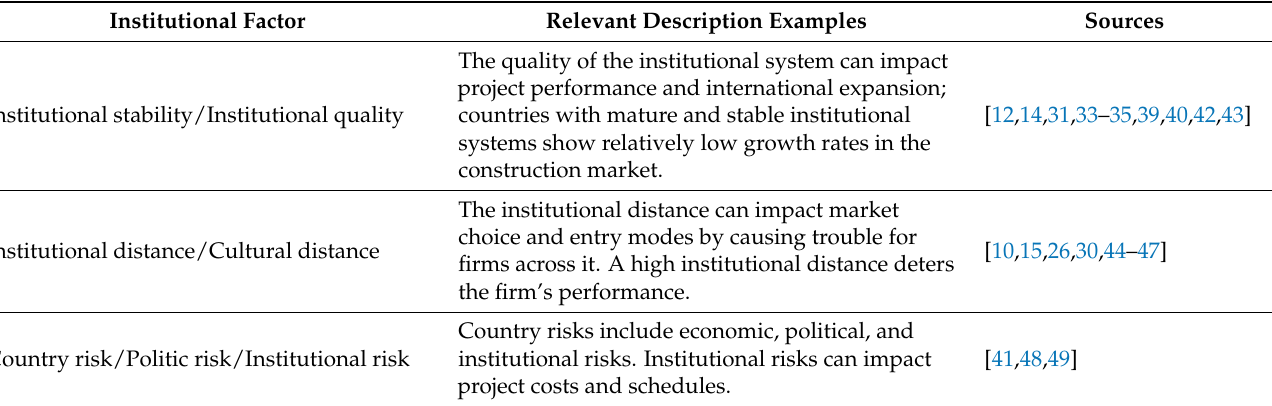
Table 1. Institutional factors potentially impacting a contractor’s international market